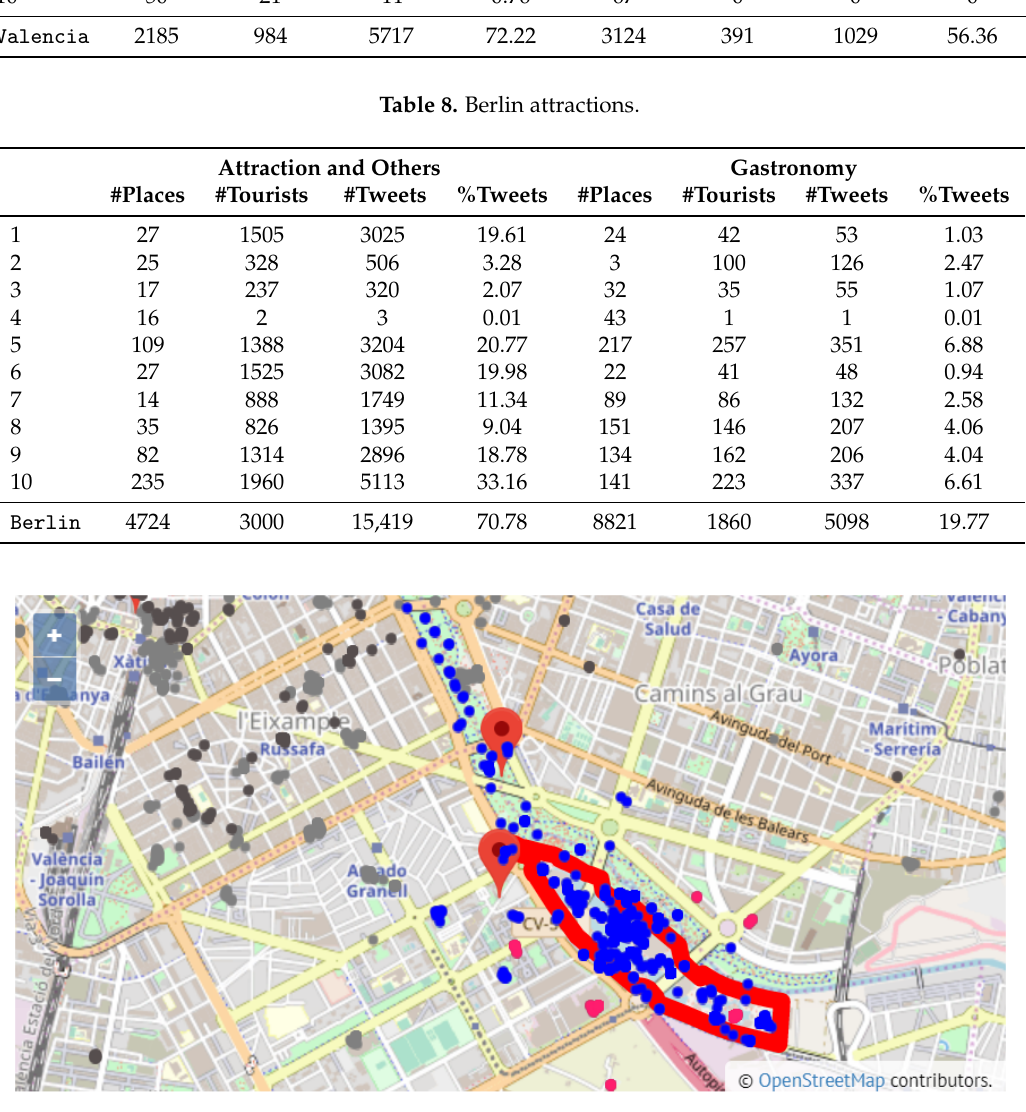
Figure 12. Zoom in on Ciudad de las Artes y las Ciencias (site